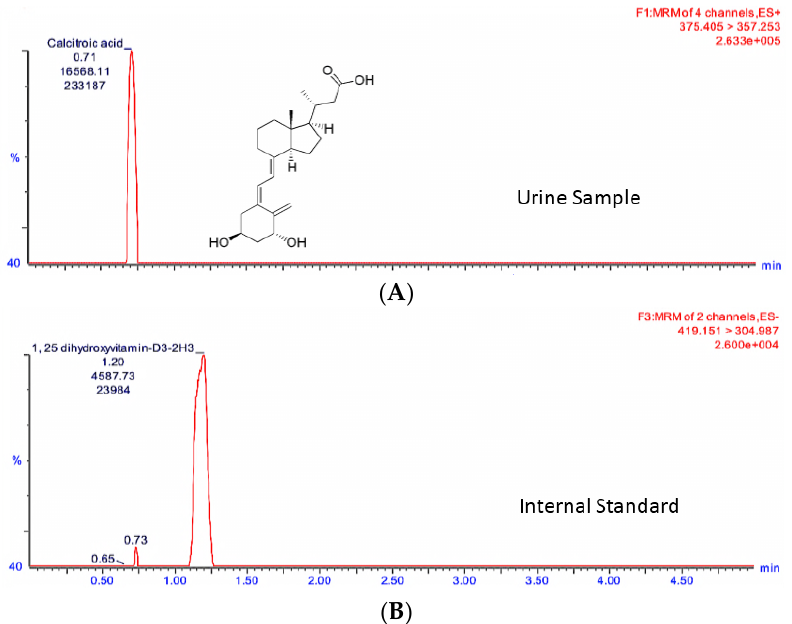
Figure 3. Representative UPLC-MS/MS chromatograms of calcitroic acid standard spiked in urine detected at 250 ng/mL and 1α,25-dihydroxyvitamin-D 3 -d 3 at 500 ng/mL (Internal Standard). The retention time is presented on the x -axis and the y -axis represent the ion count for the channel. The mass charge ratio of the parent and daughter ions, as well as the ion count for each channel, is shown. The peaks represent the most abundant ions that were used for quantification. MRM transition chromatogram of ( A ) m / z 375.4 → 357.3 for calcitroic acid and ( B ) m / z transition 419.2 → 305.0 for spiked neat internal standard 1α,25-dihydroxyvitamin-D 3 -d 3 used for